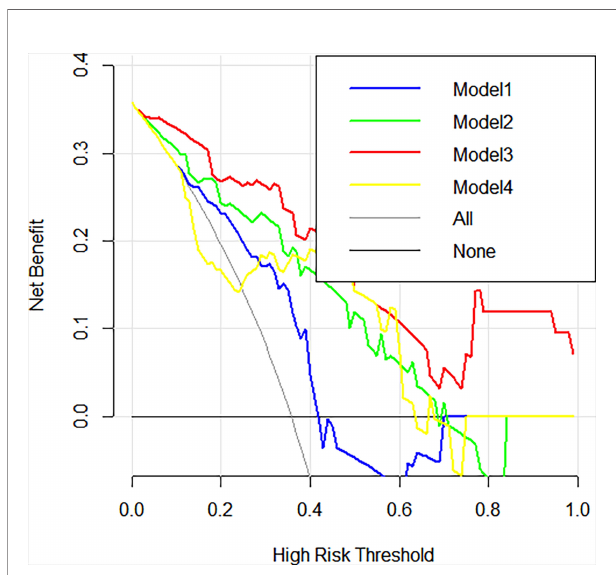
FIGURE 6 | Decision curve analysis (DCA) curves. Decision curve analysis of the 4 radiomics models in the testing cohorts. The x-axis indicates the threshold probability, while the y-axis indicates the net bene fi t. The gray line indicates the hypothesis that all the patients achieved an SLN metastasis, and the black line indicates the hypothesis that all the patients achieved non-SLN